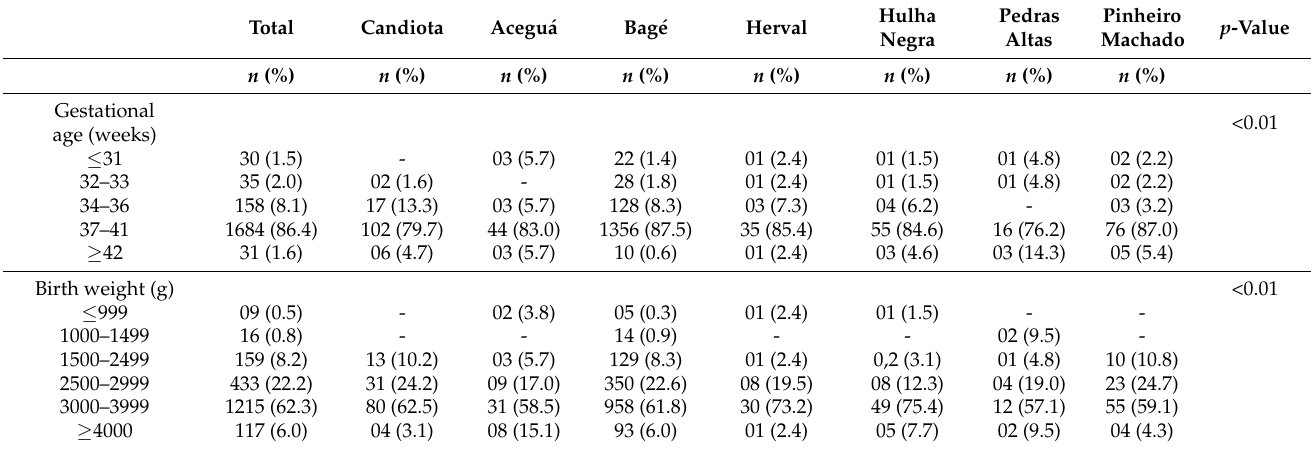
Table 4. Gestational age and birth weight by